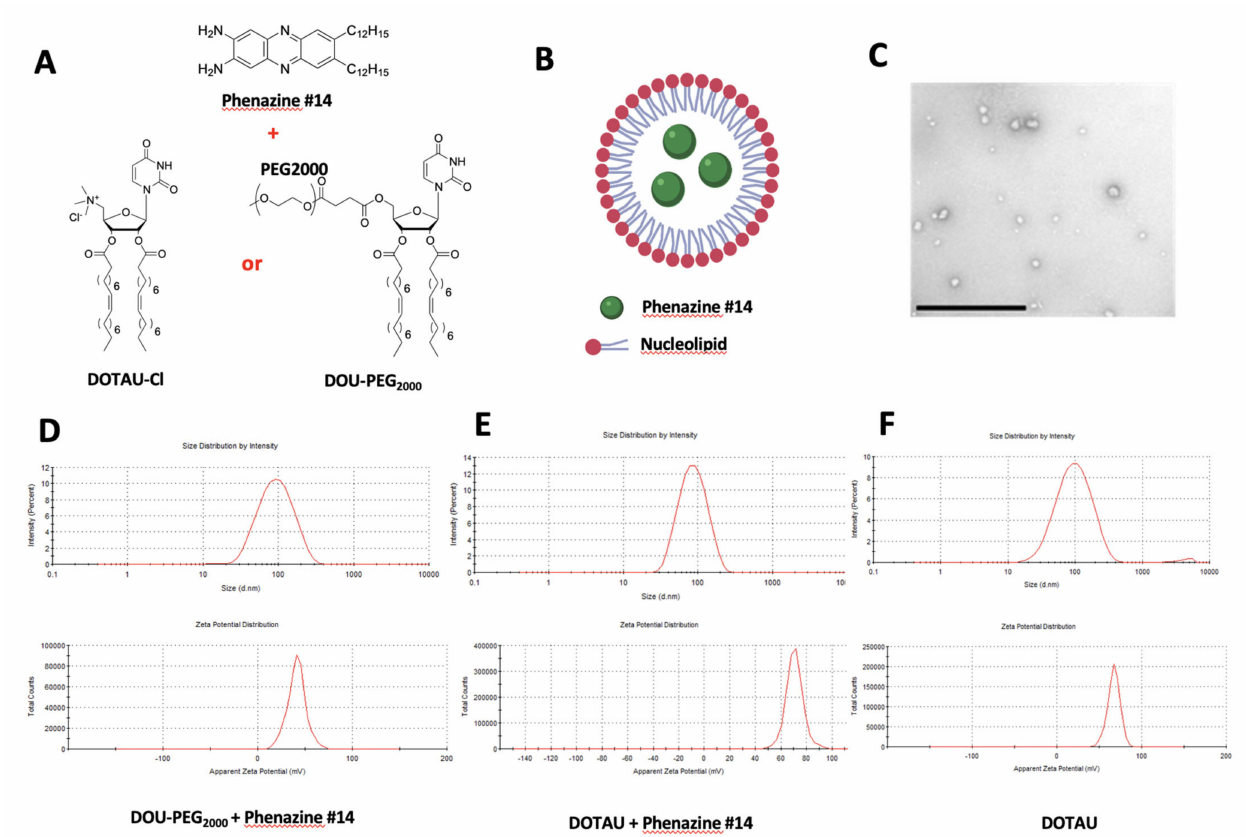
Figure 1. ( A ) Phenazine #14 formulation with DOU-PEG2000 (N-[5 (cid:48) -(2 (cid:48) ,3 (cid:48) -dioleoyl)uridine]-N (cid:48) ,N (cid:48) ,N (cid:48) -trimethylammonium tosylate)or DOTAU (5 (cid:48) -PEG2000-2 (cid:48) ,3 (cid:48) -dioleoyluridine). ( B ) Schema of phenazine #14 (in green) encapsulation with the nucleolipids (not to scale). ( C ) TEM image showing NP DOU-PEG2000 (bar = 1 µ M). ( D ) Dynamic light scattering experiment recorded on NPDOU-PEG2000 + phenazine 14 samples showing objects of 78.6 nm in diameter (polydispersity index of 0.222). Zeta potential of these objects, 41.2 mV (Zeta deviation 9.41). ( E ) Dynamic light scattering experiment recorded on NPDOTAU+ phenazine 14 samples showing objects of 74.9 nm in diameter (polydispersity index of 0.182). Zeta potential of these objects, 71.1 mV (Zeta deviation 6.37). ( F ) Dynamic light scattering experiment recorded on NPDOTAU samples showing objects of 83.8 nm in diameter (polydispersity index of 0.257). Zeta potential of these objects, 67.5 mV (Zeta deviation